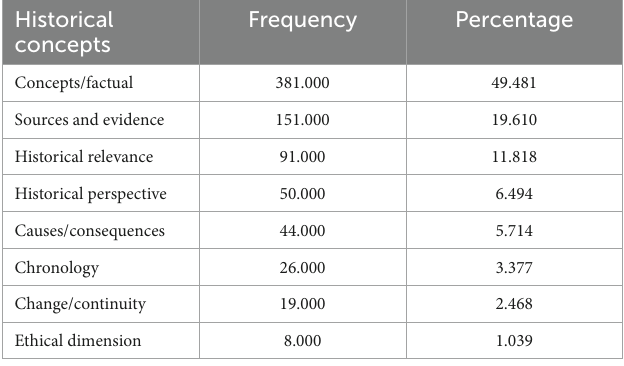
TABLE 12 First and second-order concepts in the textbook activities.